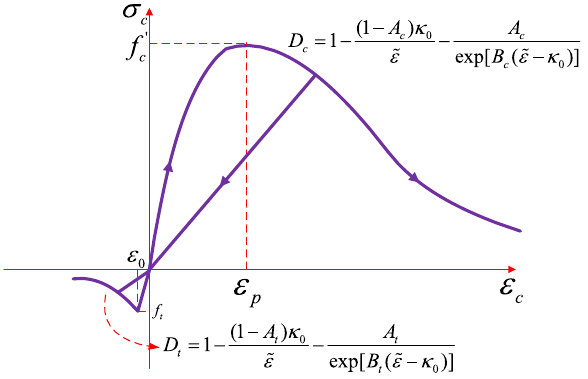
Fig. 10 Scheme of Mazars damage